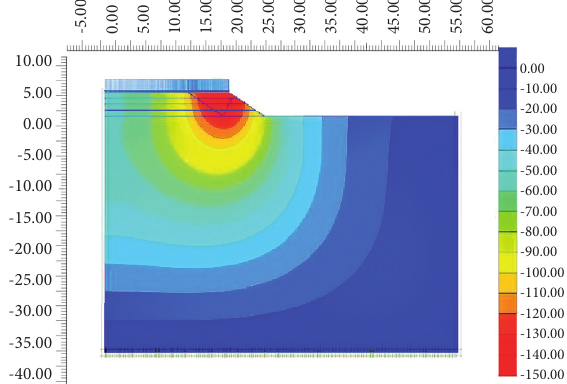
Figure 5: Vertical displacement of ground surface.